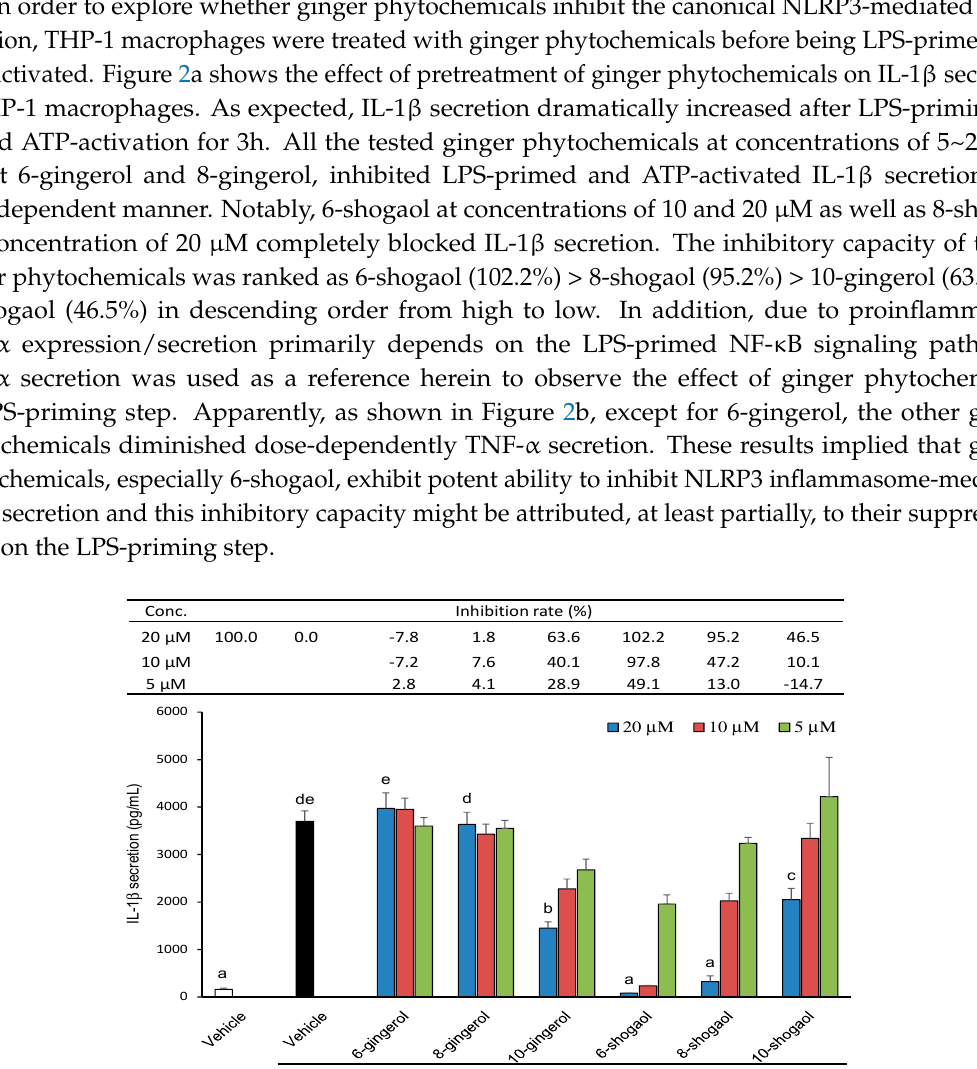
Figure 1. Chemical structure ( a ) and cytotoxic effect ( b ) of ginger phytochemicals. The phorbol 12- myristate 13-acetate ( PMA ) -differentiated THP-1 macrophages were treated with ginger phytochemicals at concentrations of 5~40 μ M for 24 h. The cell viabilities were then assessed with 3- (4,5-dimethyldiazol-2-yl)-2,5-diphenyl tetrazolium bromide (MTT) method. Data are expressed as the mean ± SD of triplicate independent experiments. Values of the ginger phytochemicals at concentration of 40 μ M with different superscript letters are significant different from one another ( p <